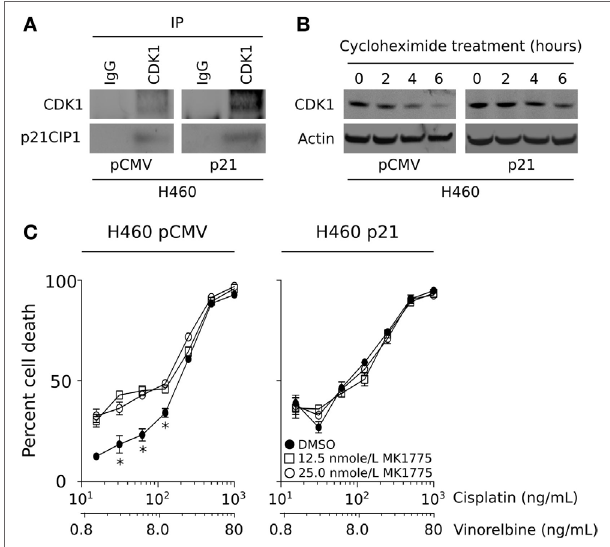
FigUre 4 | CDK1 protein is stabilized by p21, and WEE1 inhibition improves the sensitivity of brachyury-high/p21-low carcinoma cells. (a) Co- immunoprecipitation of CDK1 and p21 in lysates from H460 cells expressing either a control pCMV or a vector encoding p21. (B) CDK1 protein stability was evaluated in the H460 tumor cell pair following the addition of 100 µg/mL cycloheximide for the indicated time points. (c) Impact of MK-1775 pre- treatment (at indicated doses) on the sensitivity of H460 cells expressing a control pCMV, but not a p21 vector, to killing by chemotherapy. The data depicting the stability of CDK1, and chemotherapy sensitivity are representative of two independent